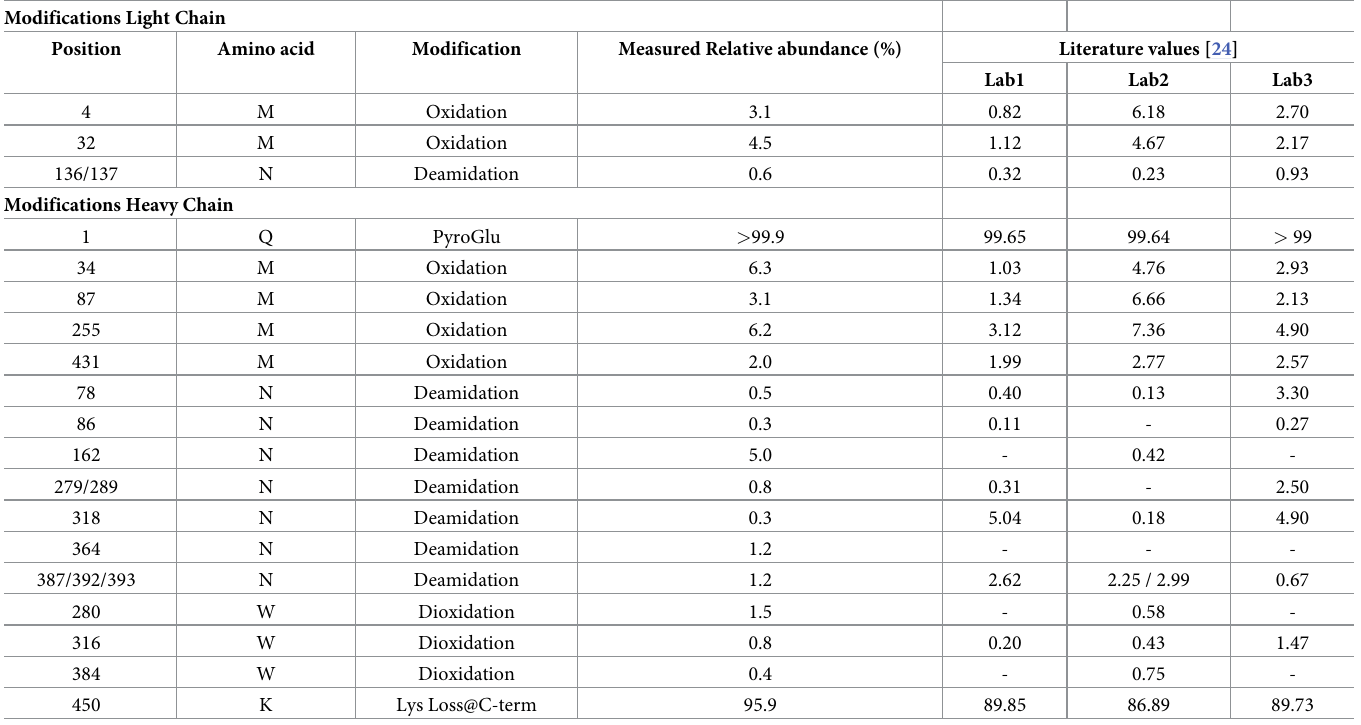
Table 2. NIST-RM PQAs identified using MAM workflow and their relative quantification. Modifications Light Chain